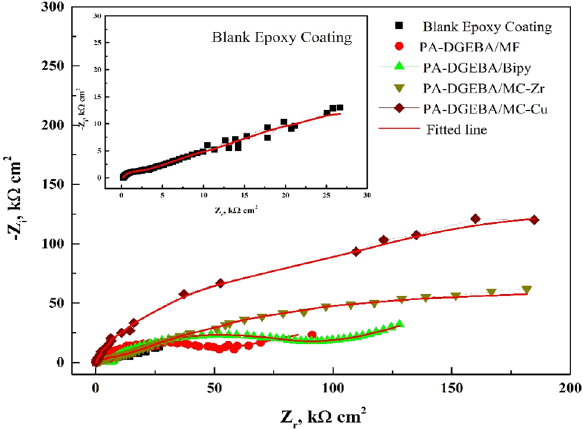
Figure 5. Nyquist plots with fitted lines for different modified epoxy coated steel films against blank conventional epoxy after immersion in oil-wells formation